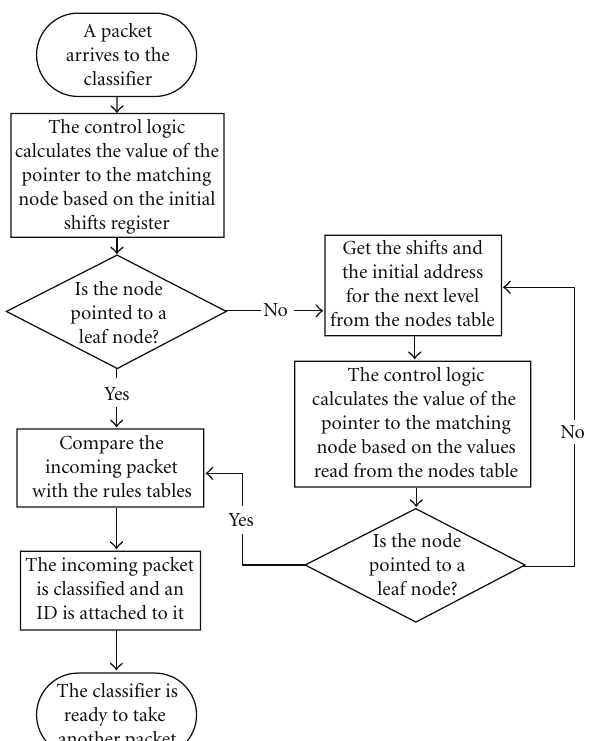
Figure 6: A flow chart for classifying the incoming packets.